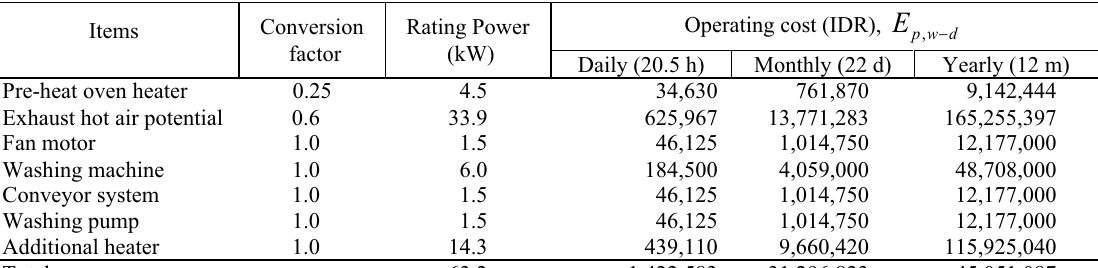
Table 2. Energy consumption cost for scrap aluminium